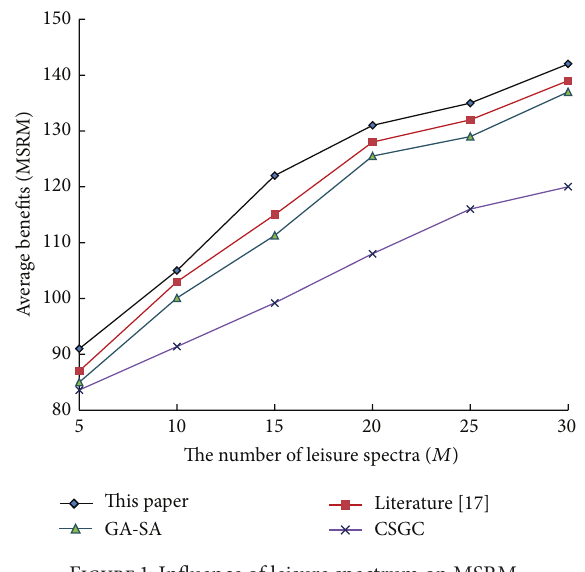
Figure 1: Influence of leisure spectrum on MSRM.